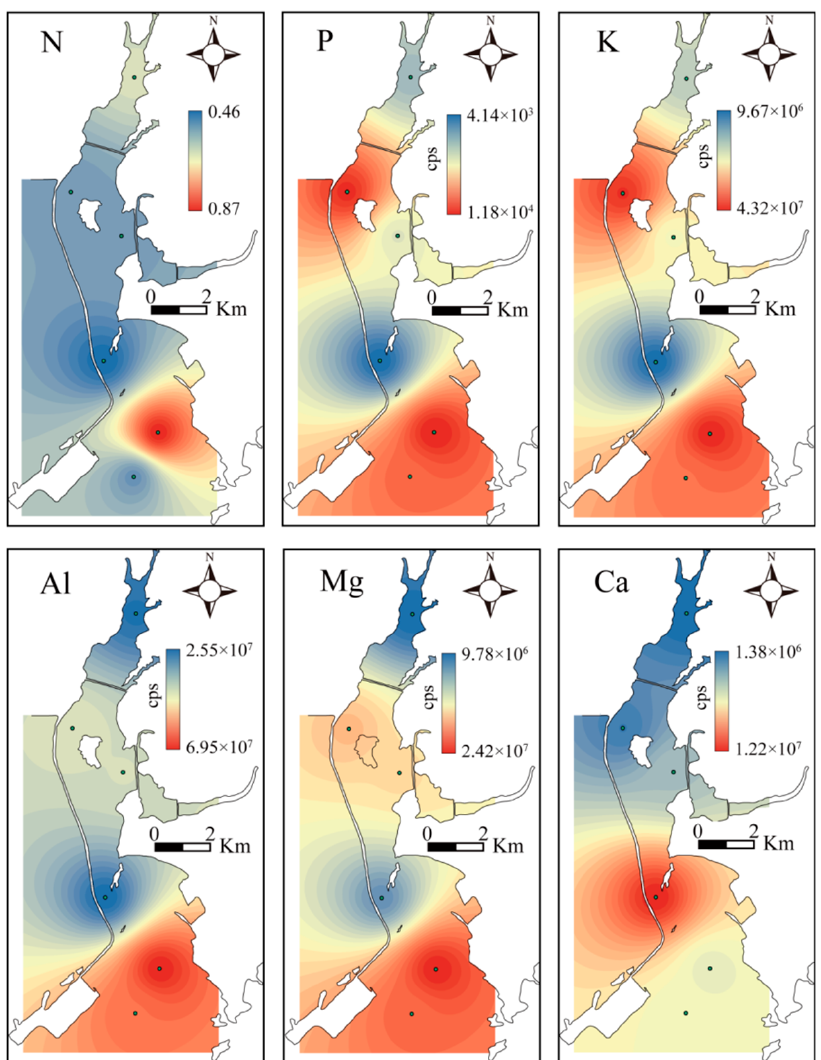
Figure 11. Spatial distribution of N, P and other metal elements of 24 sediment samples in the Lu’erhuan River Sea area of Qinzhou Bay, Guangxi Province.